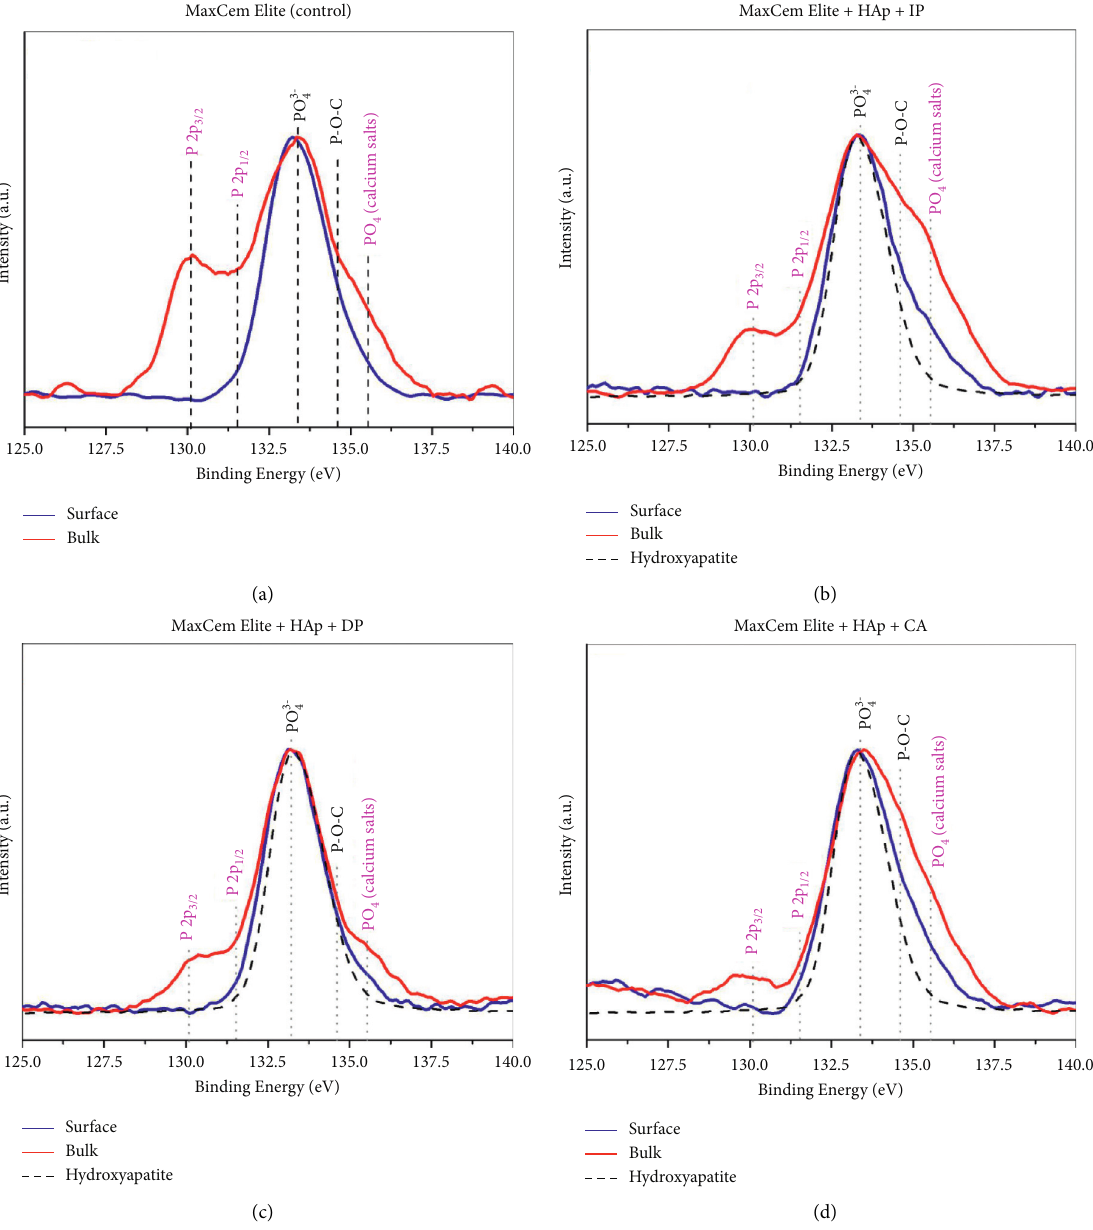
Figure 4: High-resolution P2p spectra of (a) Maxcem Elite (control), (b) Maxcem Elite+HAp +IP, (c) RelyX U200 +HAp +DP, and (d) RelyX U200+HAp +CA. The blue lines show the spectra obtained from the surface, while the red spectra were obtained from the bulk. The dashed lines show the spectrum of HAp, which was inserted for comparison purposes. The chemical species assigned to magenta are those that appeared in the spectra, mostly in